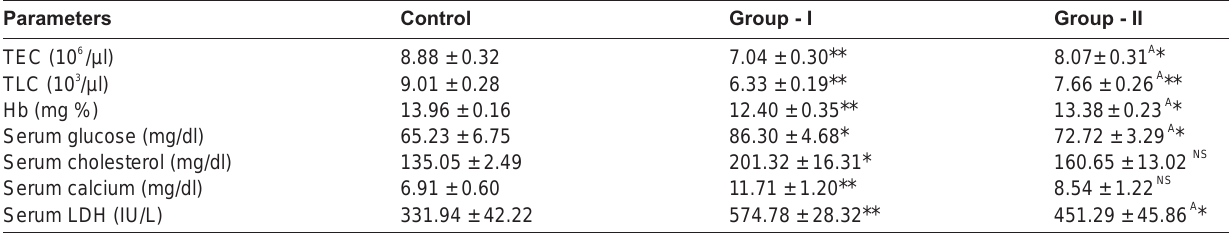
Table-1. Effect of arsenic alone and with TPE on haematological and serum bio-markers parameters (Mean ± SEM) (n=8).